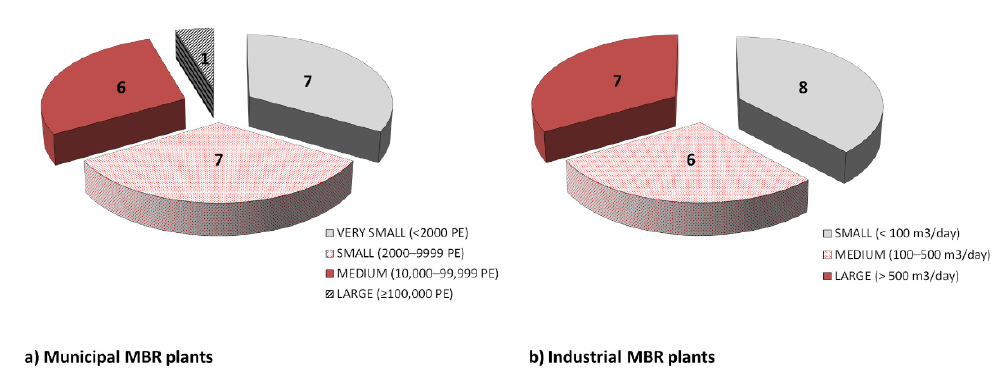
Figure 4. Classification of the MBR plants investigated in the second step of the survey.